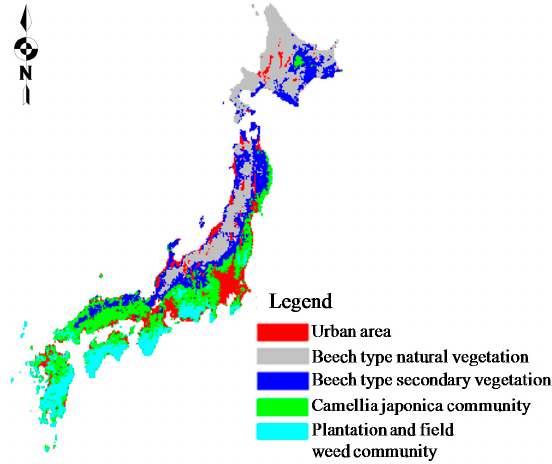
Figure 1. Generated land cover from National Oceanic and Atmospheric Administration (NOAA) Advanced Very High Resolution Radiometer (AVHRR) remote sensing imagery (example from 1996). Table 1. Statistical parameters of land cover (SD means standard deviation; CV means coefficient of variation).